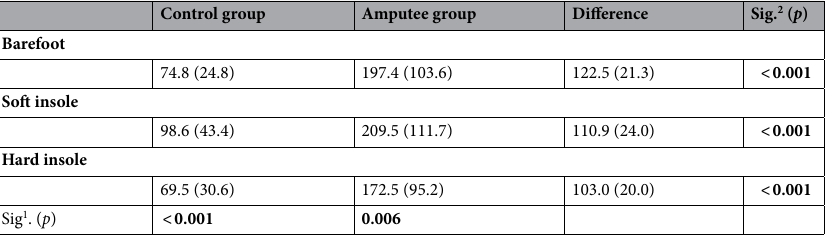
Table 4. Comparison of length of movement of the barycenter between the different insoles in each experimental group. Significant values are in [bold]. Mean (standard deviation) [IC. For the mean (at 95%)]. 1 Friedman Test. 2 Mann-Whitney Test. Length of movement of the barycenter